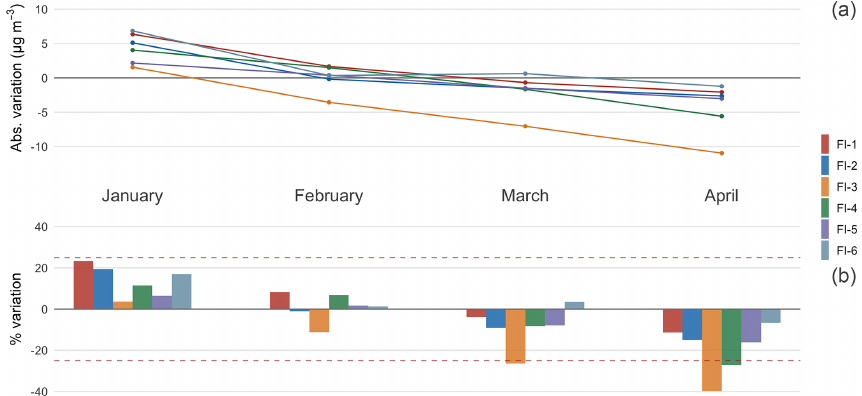
Figure 3. Florentine agglomeration: PM 10 (a) absolute variation and (b) percentage variation between monthly means of 2020 and 2017–